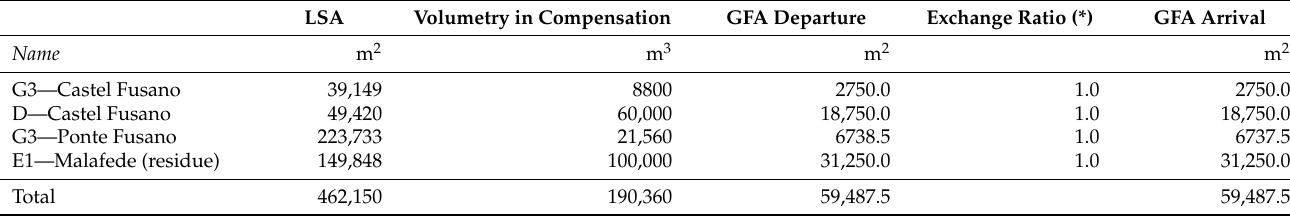
Table 9. Compensation hypothesis (“Certain